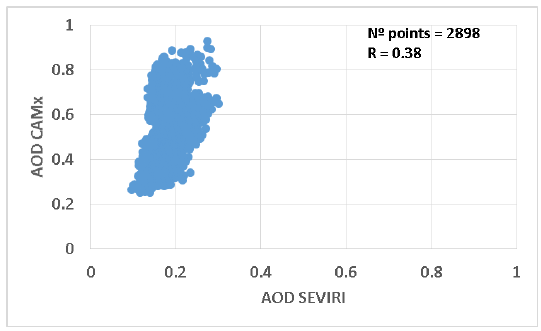
Figure 8. Scatterplot of monthly mean AOD for each grid cell from CAMx and SEVIRI for May